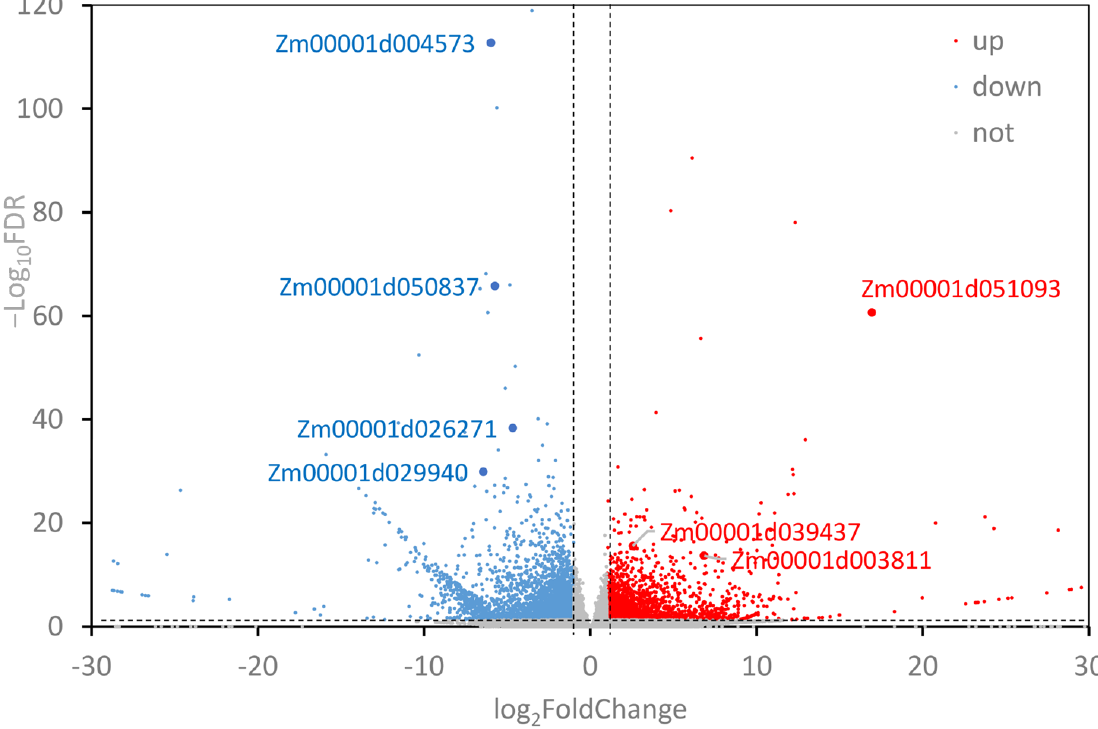
Figure 2. Screening of the differentially expressed genes. Red dots indicate up-regulated genes and blue dots indicate down-regulated genes (FDR < 0.05 and |Log 2 Fold Change|> 1).